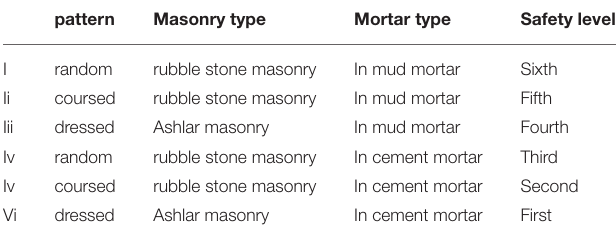
TABLE 1 | Grading of stone masonry types according to Arya